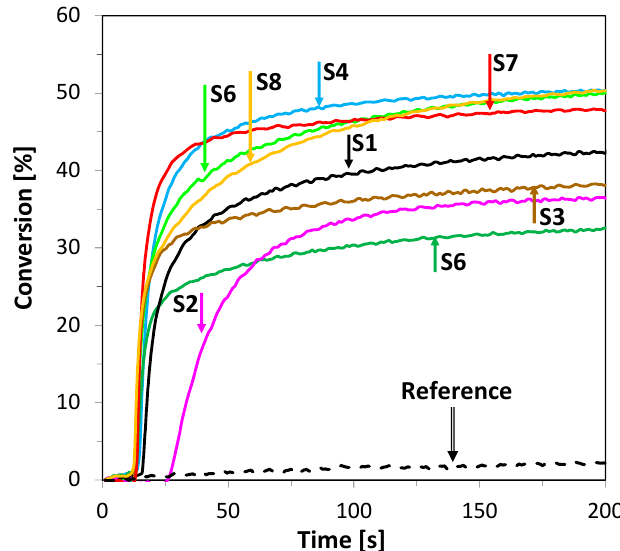
Figure 7. Conversion of double bonds of trimethylolpropane triacrylate (TMPTA) recorded during free-radical photopolymerization with photoinitiating systems (PISs) based on (HIP (1 wt.%) and 2-amino-4,6-diphenyl-pyridine-3-carbonitrile derivatives (0.1 wt.%) under UV-LED 365 nm (intensity at the surface of sample 1.59 mW/cm 2 ) irradiation. The irradiation starts at t = 10 s.